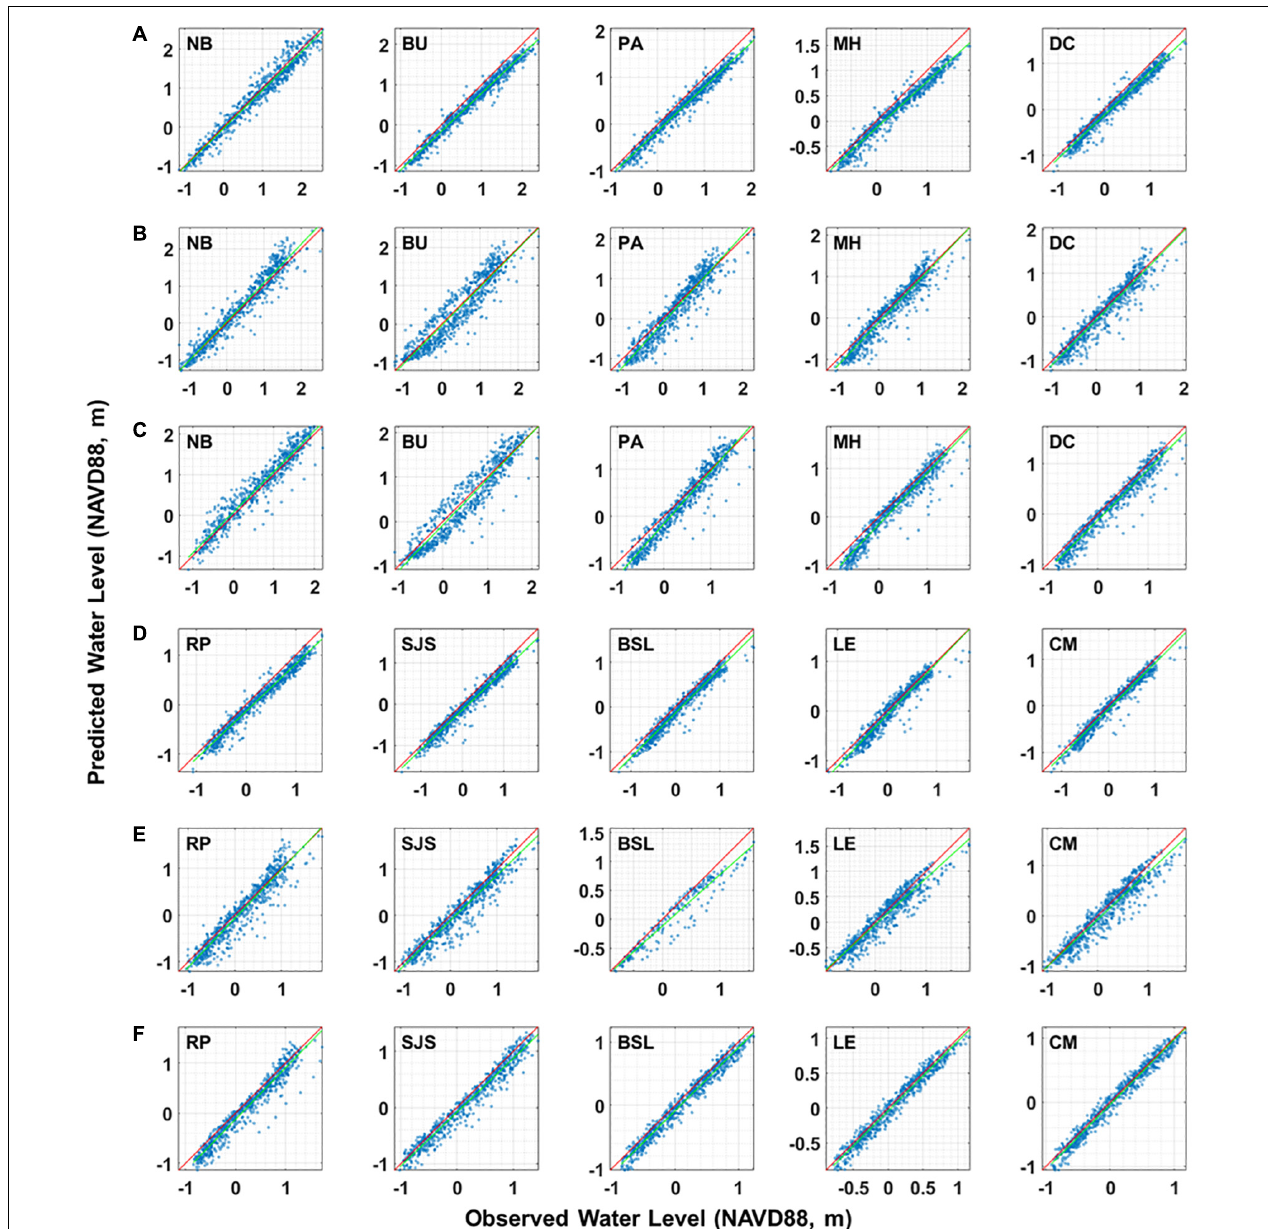
FIGURE 7 | Scatter comparisons of simulated and observed water levels at 10 tidal stations during three simulation periods in the DBE; (A,D) Irene and Lee: August 20 to September 20, 2011; (B,E) Sandy: October 20 to November 20, 2012; (C,F) Isabel: September 01 to 30, 2003. The red line represents the 1-to–1 fit and the green line represents the linear correlation between model and